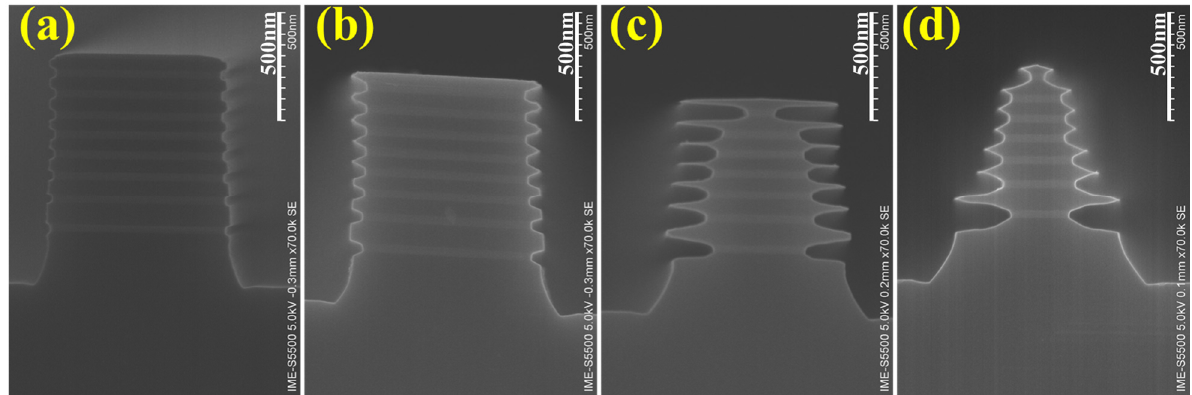
Figure 9. The SEM cross–section images of Sample IV after digital etching with 31.5% HNO 3 -dBOE q-ALE at ( a ) 40 cycles, ( b ) 100 cycles, ( c ) 200 cycles, and ( d ) 300 cycles.